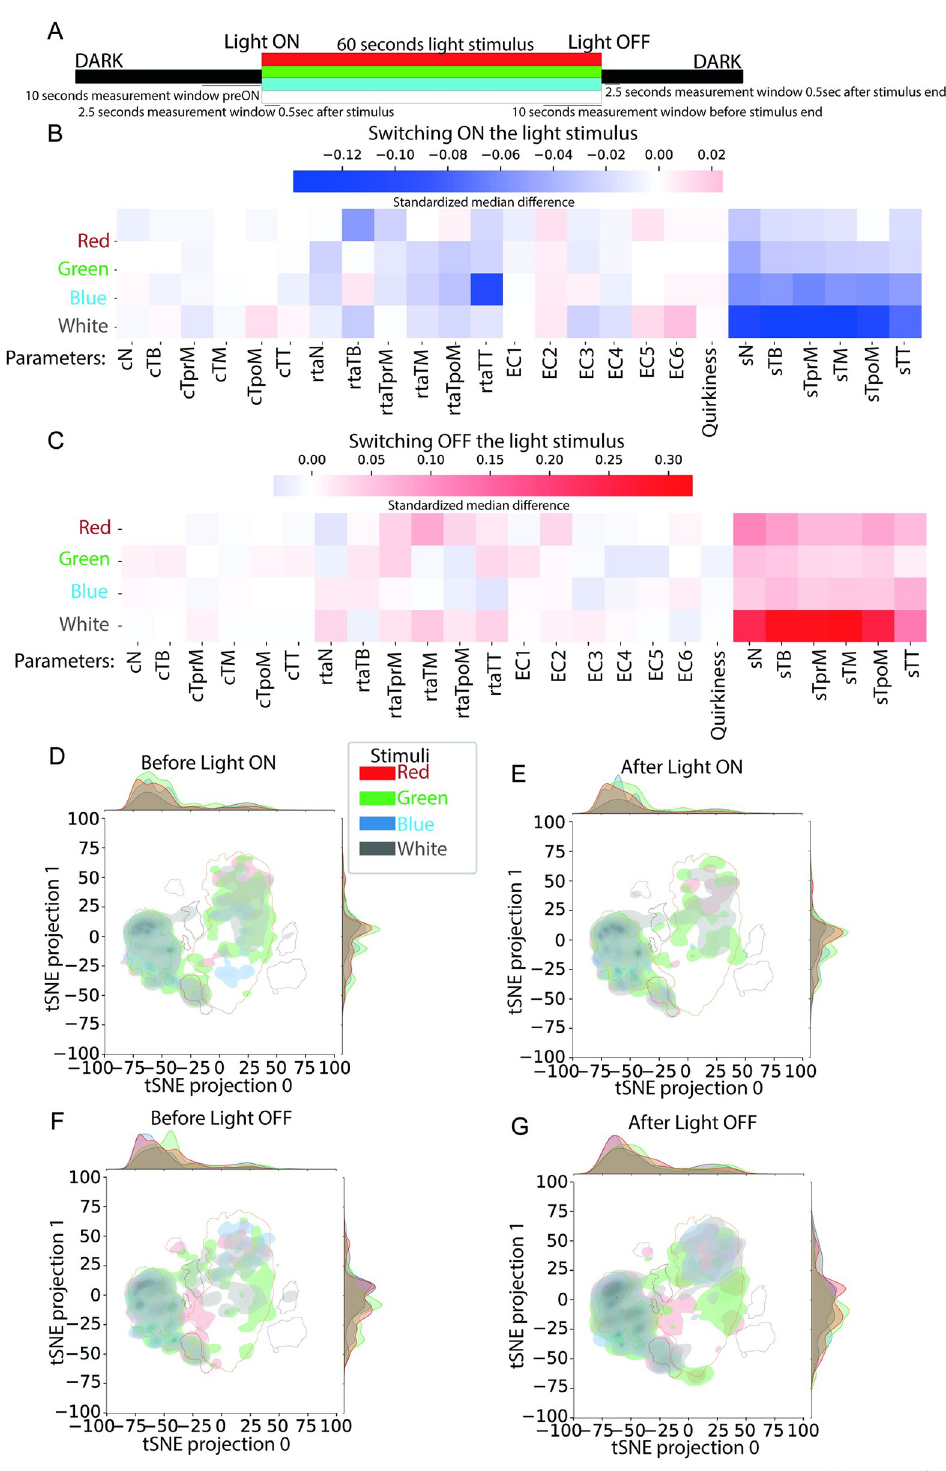
Fig 6. Postural dynamics and behavioral space occupancy are modulated by different light stimuli. (A) Design of the light stimulus: A 60-second long window of stimuli is presented at the 30th second of the experiment. Different types of light stimuli are used, namely red, green, blue, and white. We observe the changes at light ON event by comparing a 10-second window before the event (before light ON) and a 2.5-second long window after 0.5 seconds of the onset of light ON (after light ON). Similarly, we define 2 windows before and after the light OFF event to study